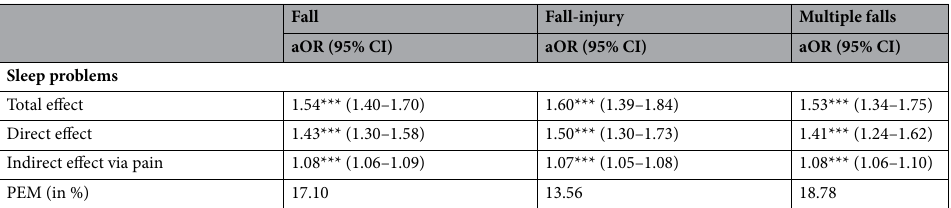
Table 4. Direct and indirect effects of sleep problems on falls, fall-related injuries, and multiple falls. Notes: aOR: OR adjusted for age, sex, education, marital status, living arrangements, self-rated health, ADL/ IADL difficulty, MPCE quintiles, religion, caste, place of residence and regions; PEM: Percent of effect mediated.